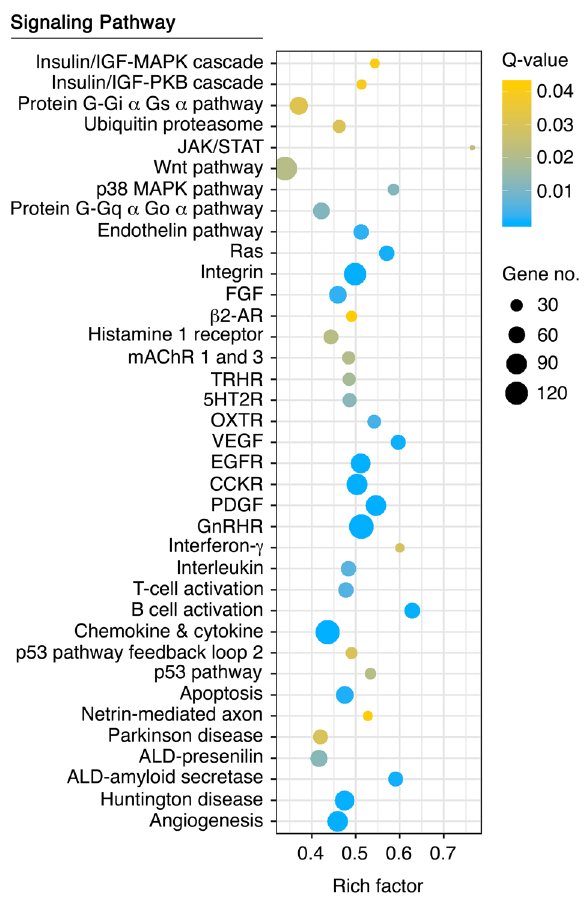
Figure 6. Pathway enrichment analysis among DEGs during spermatozoa differentiation and maturation using the PANTHER Classification System. The plot generated with the ‘ggplot2’ R package (https:// ggplo t2. tidyv erse. org) shows the 37 most highly enriched signaling pathways (FDR < 0.05) in SPZ EJ . The left Y-axis shows the PANTHER pathway, whereas the X-axis shows the rich factor. A high Q-value is represented by yellow and a low Q-value is represented by